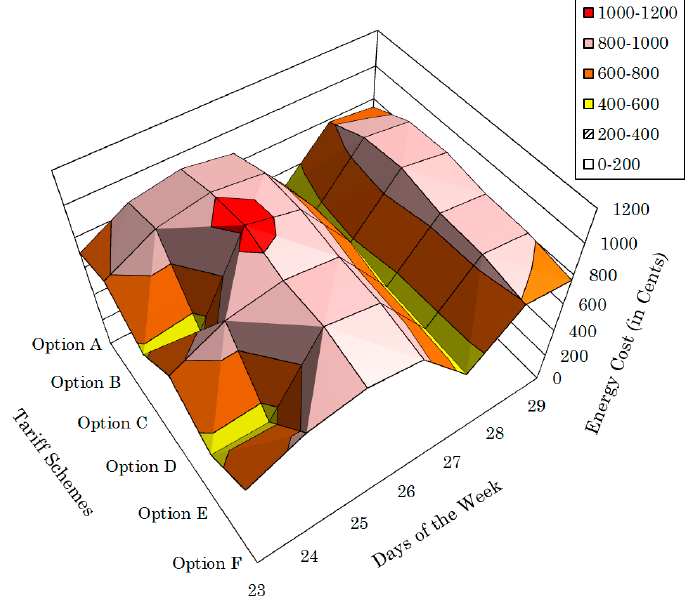
Figure 12. The consumed energy cost in cents by the ON/OFF of the controlled AC unit by employing the 6 options of ToU rates.